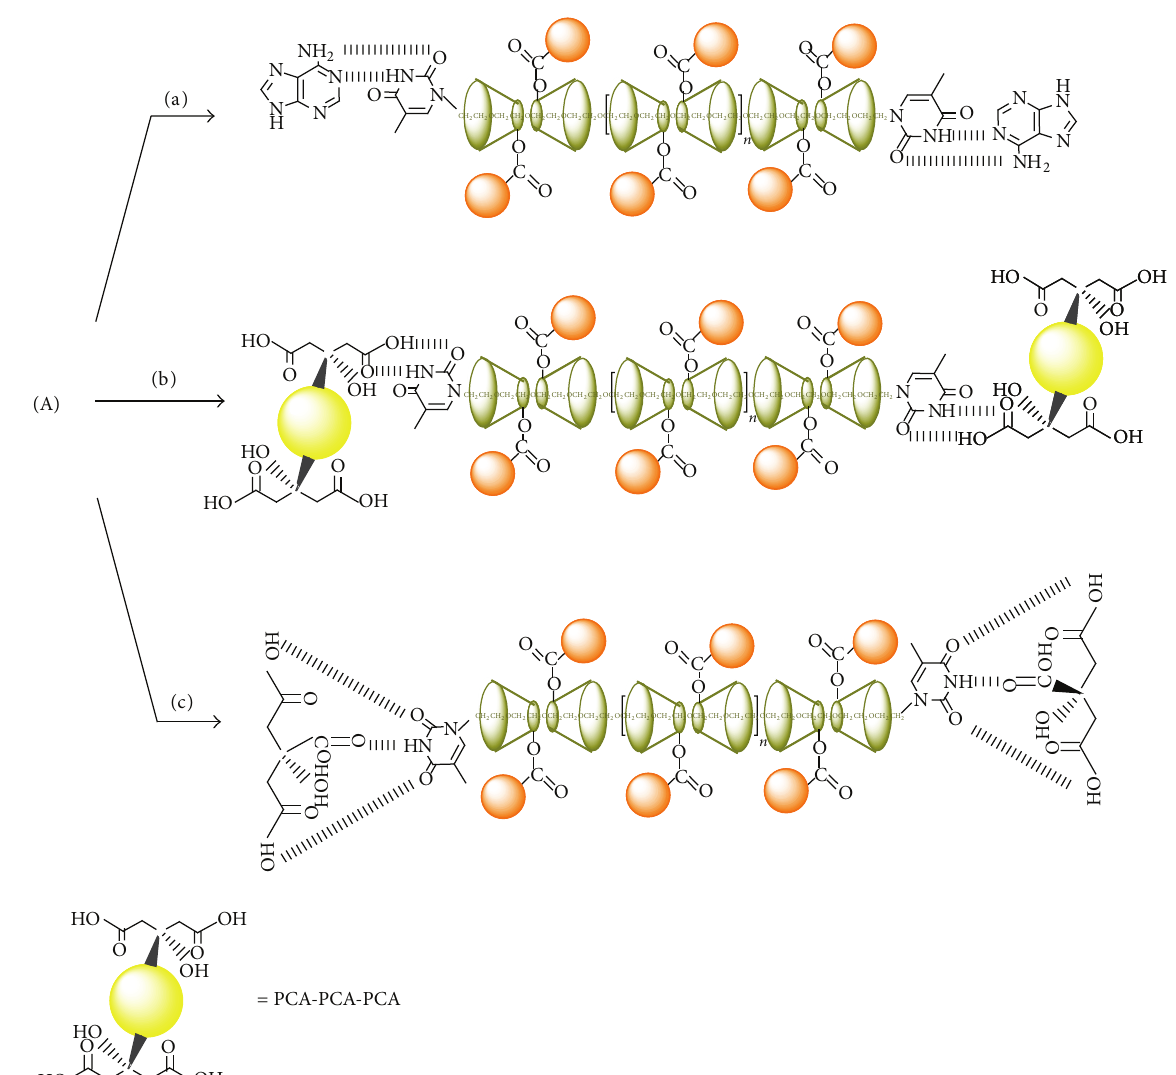
Scheme 2: Interactions between PPR and adenine (a), PCA-PEG-PCA (b), and citric acid